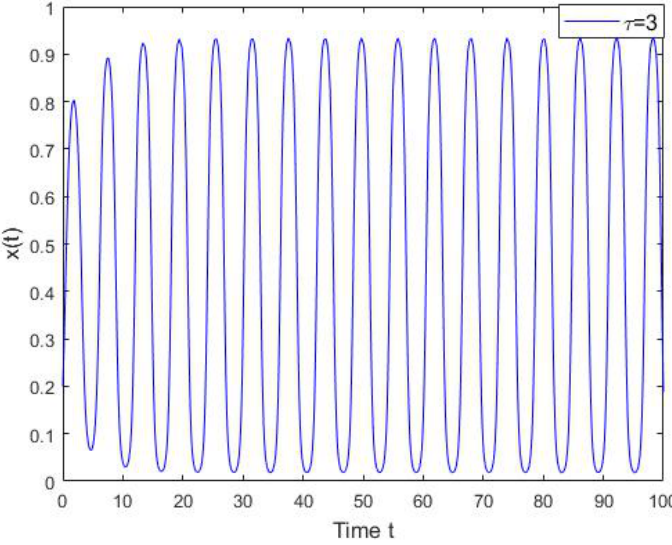
Figure 2. The oscillation of the solution of system in Equation (14), where τ =